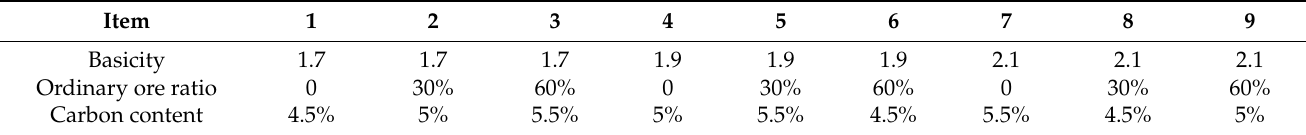
Table 4. Orthogonal experiment scheme of L 9 (3 4 ).